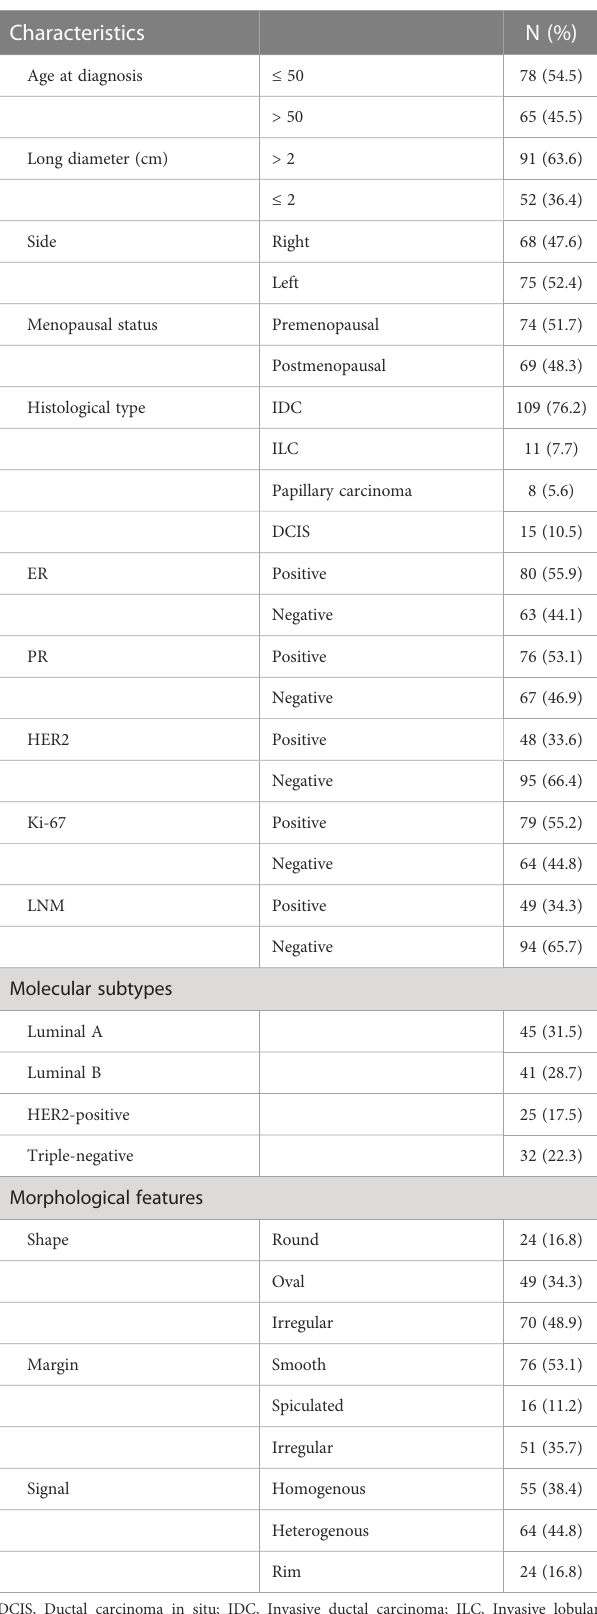
TABLE 1 Study population and histopathological